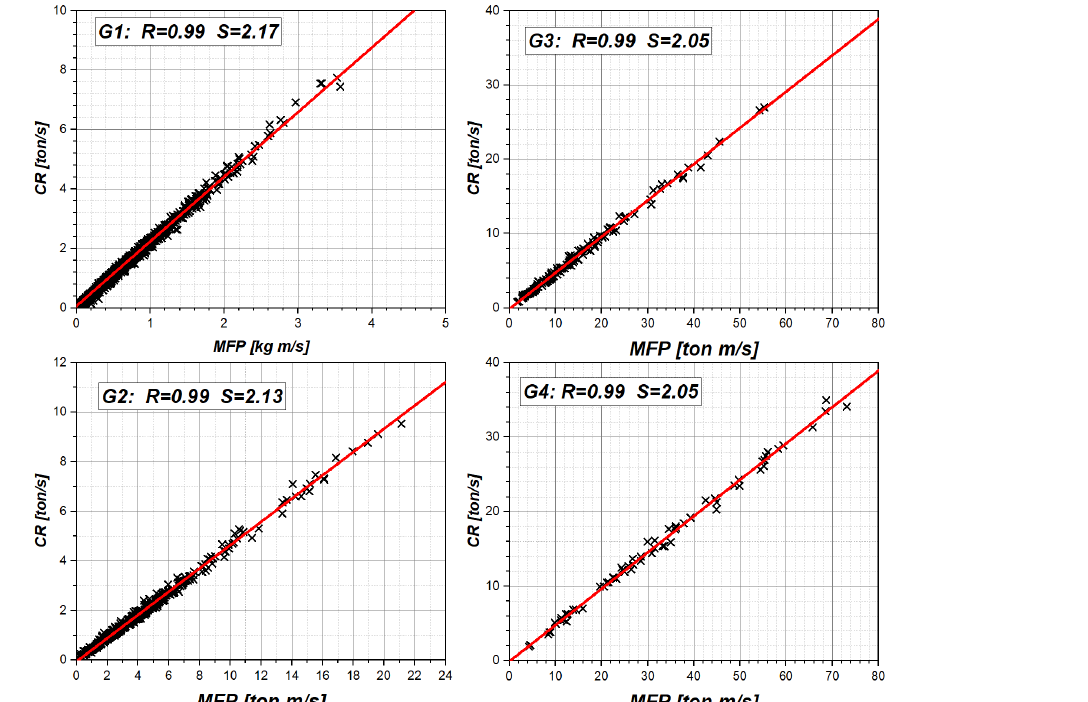
Figure 2. Scatter plots of condensation rates (CR) as a function of upward mass flux (MFP) for clouds in each of the four groups. R is the correlation coefficient; S is the slope of the linear